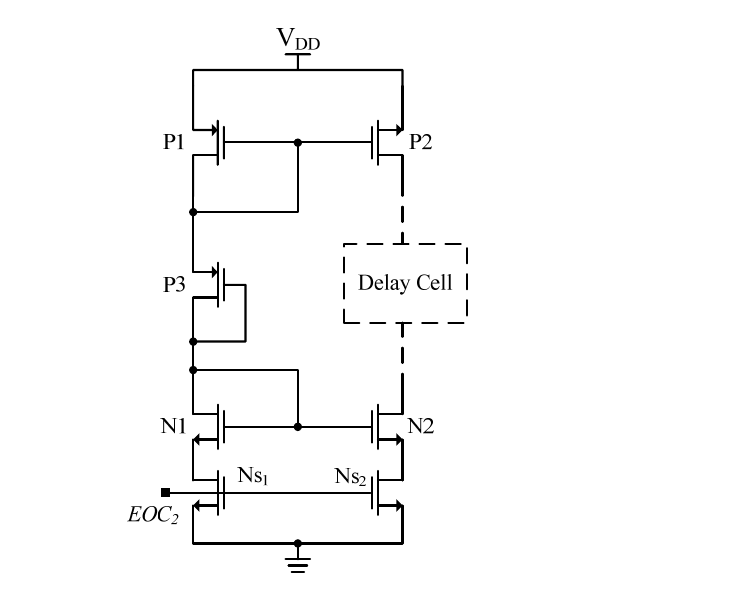
Figure 7. Schematic of thermal-compensation